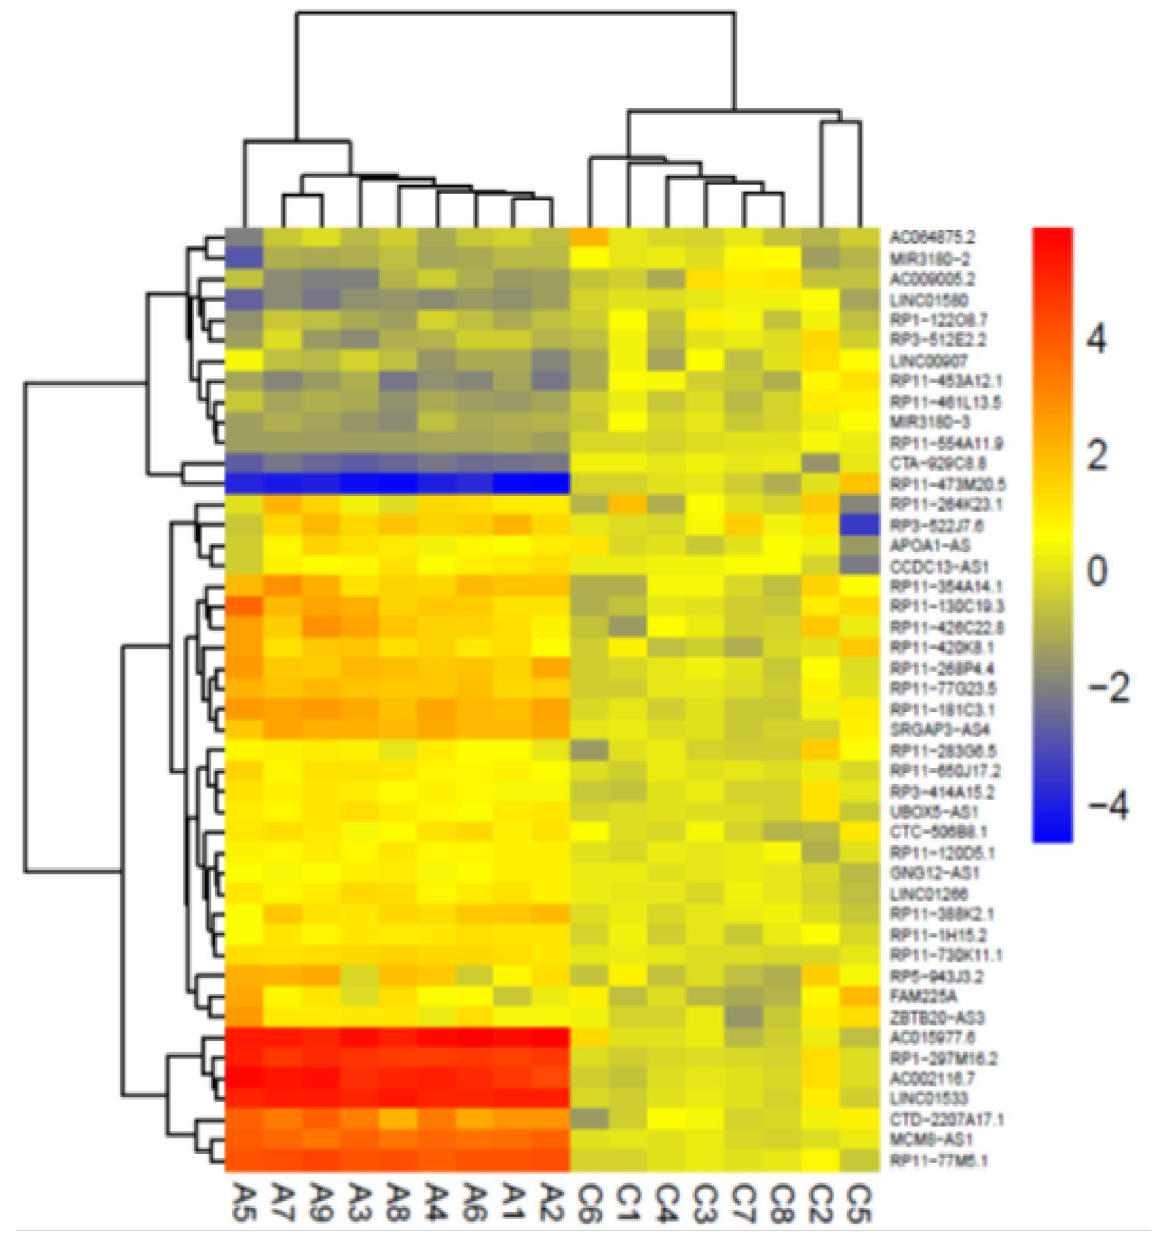
Figure 7: The heat map diagram of 46 differentially expressed lncRNAs in Alzheimer’s disease samples obtained from reanalysis of the GSE53697 RNA-seq dataset. The color legend represents from low expression (blue) to high expression (Red). C; control, A; AD